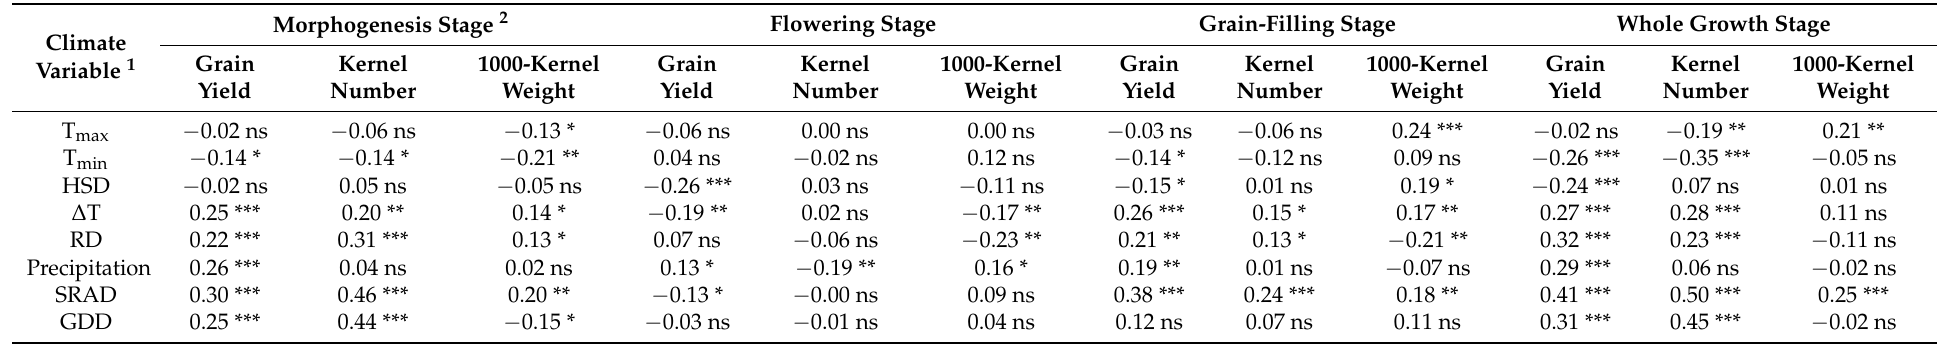
Table 3. Relationships between maize yield attributes (grain yield, yield components) and meteorological conditions during morphogenesis stage, flowering stage, grain-filling stage, and the whole growth